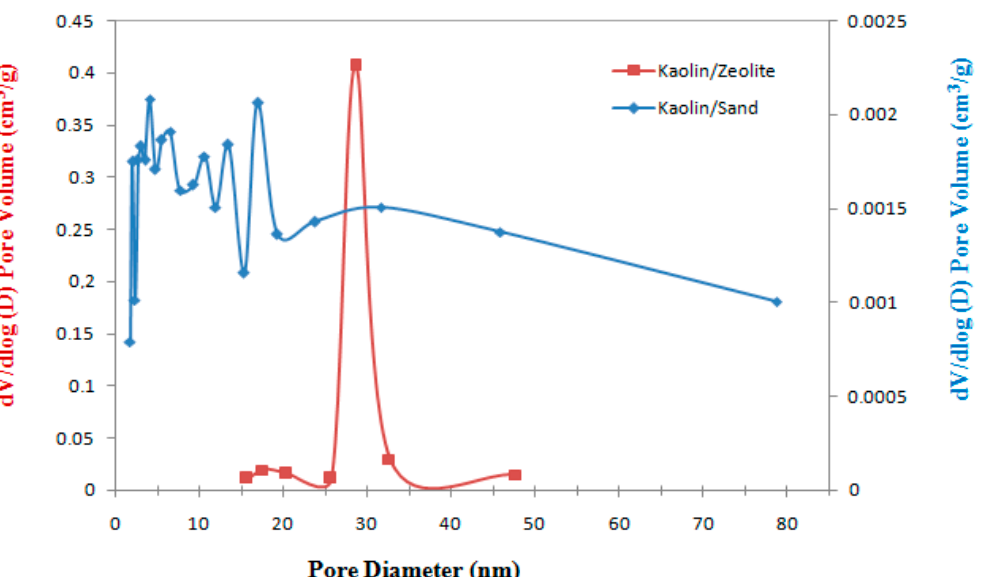
Figure 4. Distribution of pore diameters for kaolin/sand and kaolin/zeolite membranes.